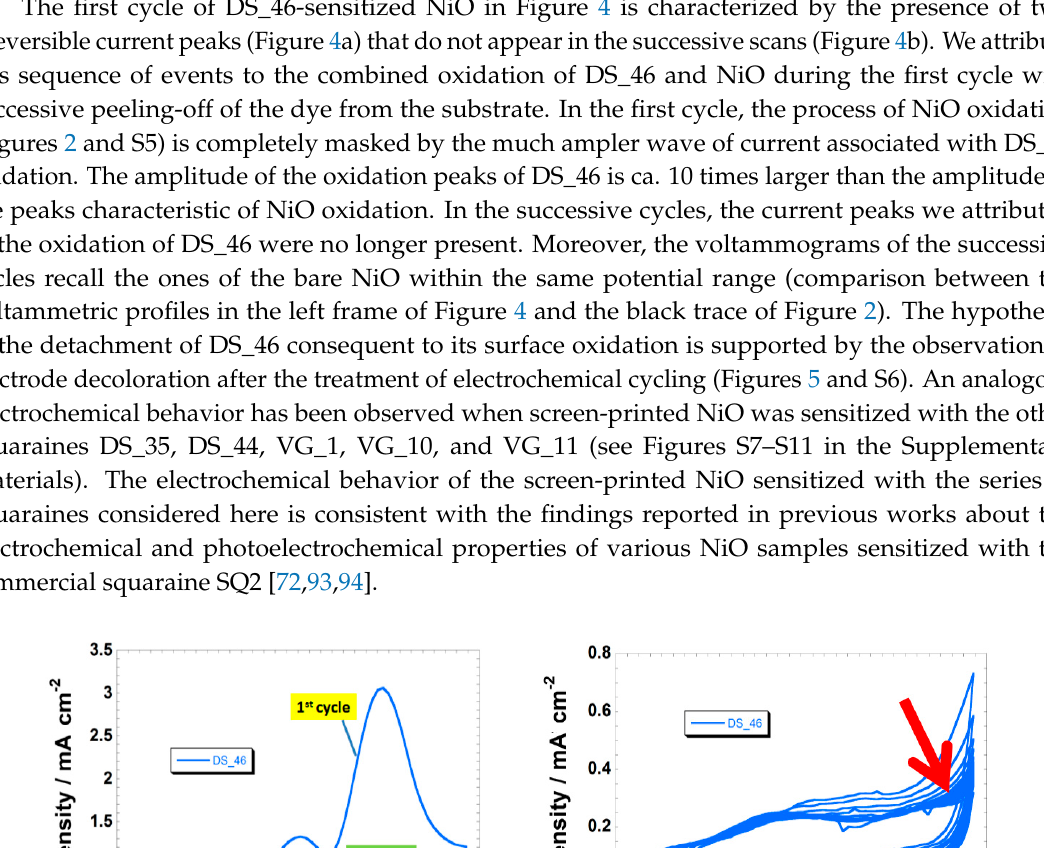
( b ) Figure 5. Photographs of DS_46-sensitized NiO film before ( a ) and after ( b ) the electrochemical cycling of Figure 4. 3.2. Analysis of the Impedance Spectra The electrochemical impedance spectra of the three-electrode cells having the bare or sensitized NiO as the working electrode have been recorded at open-circuit potential ( V OC ). The corresponding values of V OC for the cells with differently sensitized NiO electrodes are those reported in the second column of Table 1 ( vide supra ). After the assembly of the cell, its value of V OC was first measured. The impedance spectrum of the cell was recorded immediately after the determination of V OC with the cell potential kept at the given value of V OC . The impedance analysis was not conducted on the cells after the treatment of electrochemical cycling, because it has been observed that electrochemical cycling generally introduces irreversible modifications of the sensitized electrode (i.e., partial or complete desorption of the dye). It is worth mentioning that the electrochemical cycling did not provoke any structural modification in the electrode.